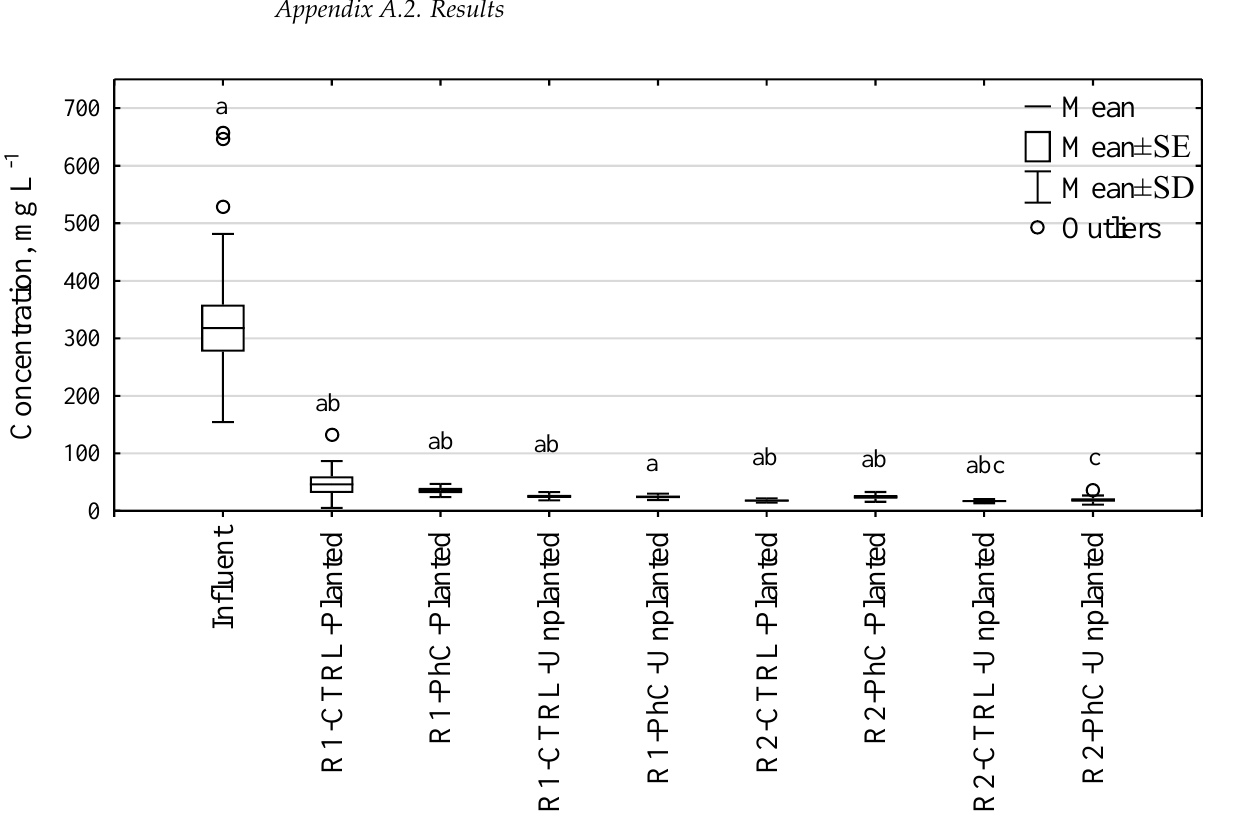
Figure A1. TOC concentration (mg L − 1 ) of wastewater from CWs. (a) Statistically significant differ- ences between the wastewater influent and effluent (Mann-Whitney U test, p < 0.05); (b) Statistically significant differences between counterpart types of columns (CTRL or PhC) with different frequen- cies of wastewater dosing (Mann-Whitney U test, p < 0.05); (c) Statistically significant differences between control wastewater and wastewater containing pharmaceuticals (Mann-Whitney U test, p < 0.05).